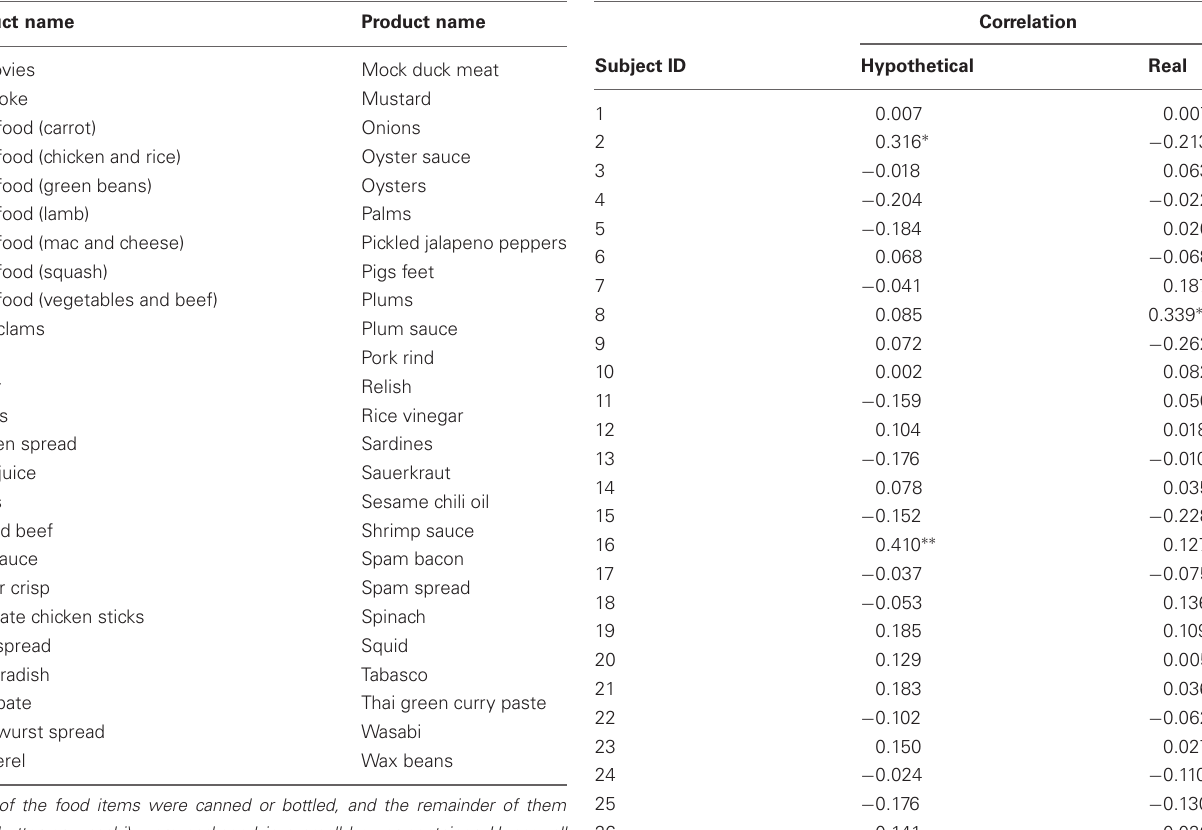
Table A1 | List of 50 aversive food items used in the study. Table A2 | Correlation between bids and